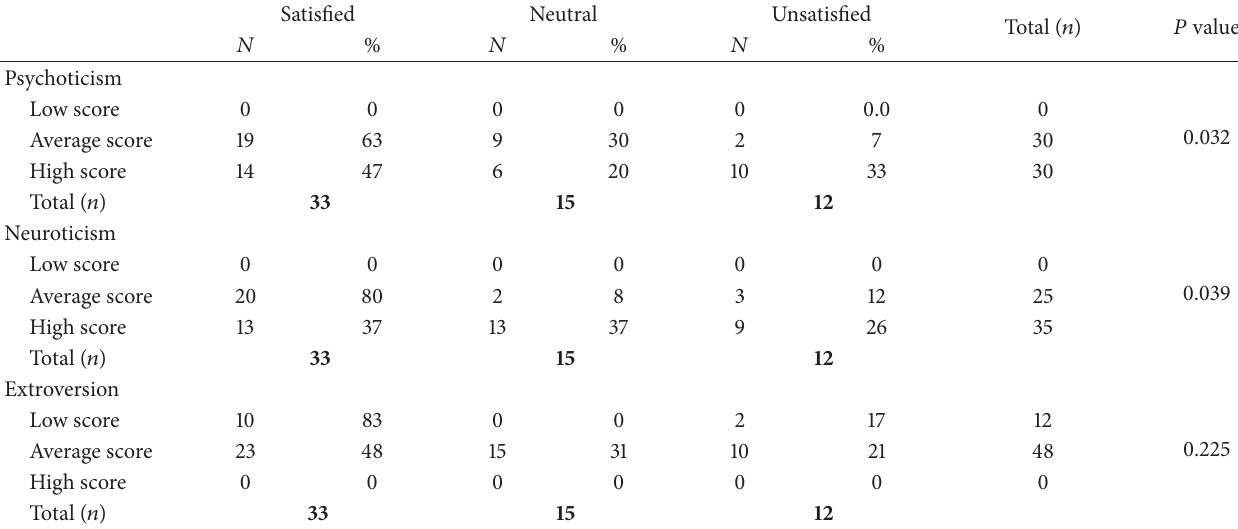
Table 5: Association between the level of patients’ satisfaction after relining and restoration of the OVD of their complete dentures and psychoticism, neuroticism, and extroversion. Satisfied